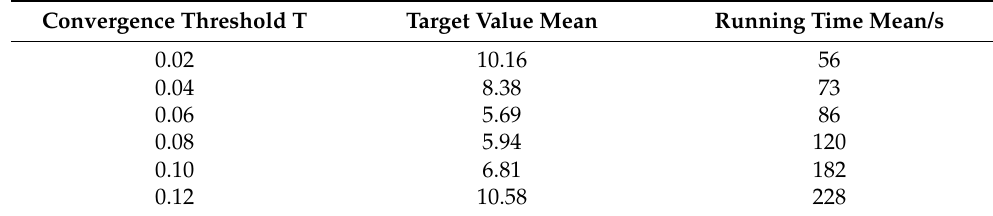
Table 1. Comparison result of T.